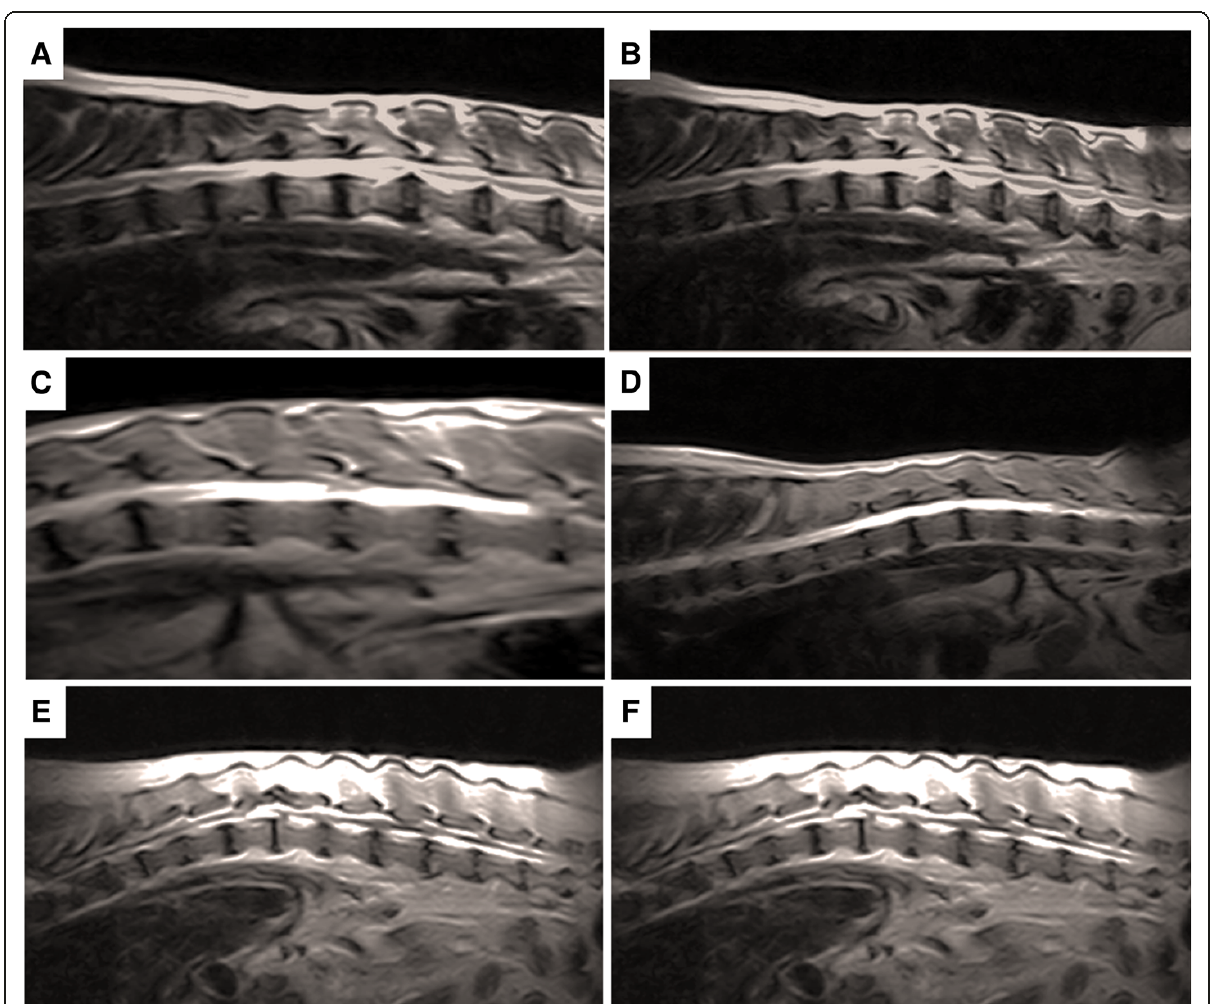
Figure 1 MRI of dogs thoracolumbar segment. In (A) the pre treatment the animals showed severe extradural compressive myelopathy ventrolateral between T11-T12 and disc protrusion at L3-L4, disc degeneration and spondylosis multifocal in thoracic and lumbar spine. In (B) after treatment the animal showed the same diagnosis at MRI without regression or progression of the previous reported. In (C) homogeneous hyperintensity maintained between T9-L2, extradural compressive myelopathy, mild to moderate between T12-T13, previous surgical procedure between T11-T13, with secondary muscle atrophy, disc dehydration multifocal in thoracolumbar spine were observed. In (D) after the treatment the same alterations were observed in the MRI. In (E) myelopathy extradural compressive between T9-T120 and T13-L1, with the presence of secondary siringohidromielia. In (F) after treatment probable thoracolumbar muscular atrophy with presence of siringohidromielia between T12-L1 and L3, and severe at T13-L1, multifocal disc dehydration in thoracolumbar